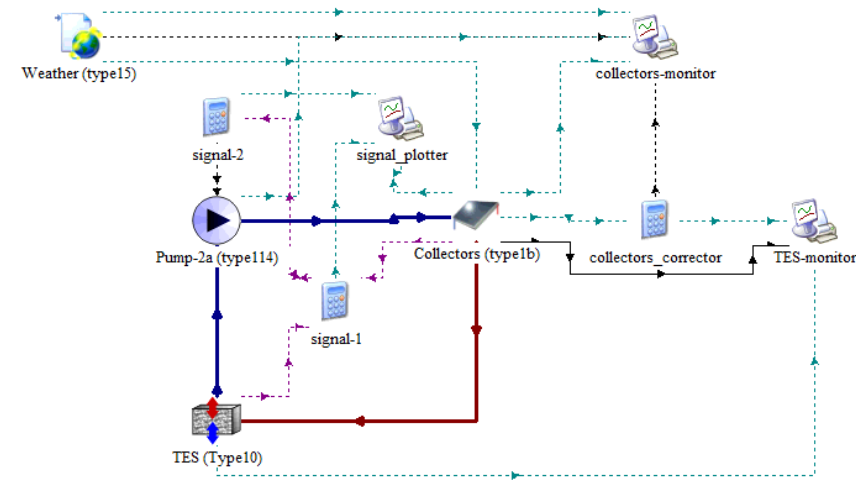
Figure 2. TRNSYS solar collectors model Figure 2 . TRNSYS solar collectors model set-up.